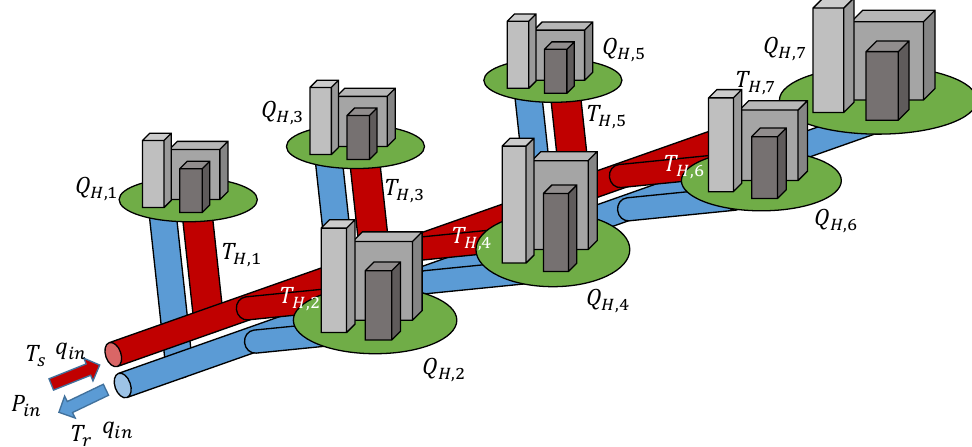
Figure 1. District heating system—a conceptual layout of how consumers are distributed along the pipes, for N house =